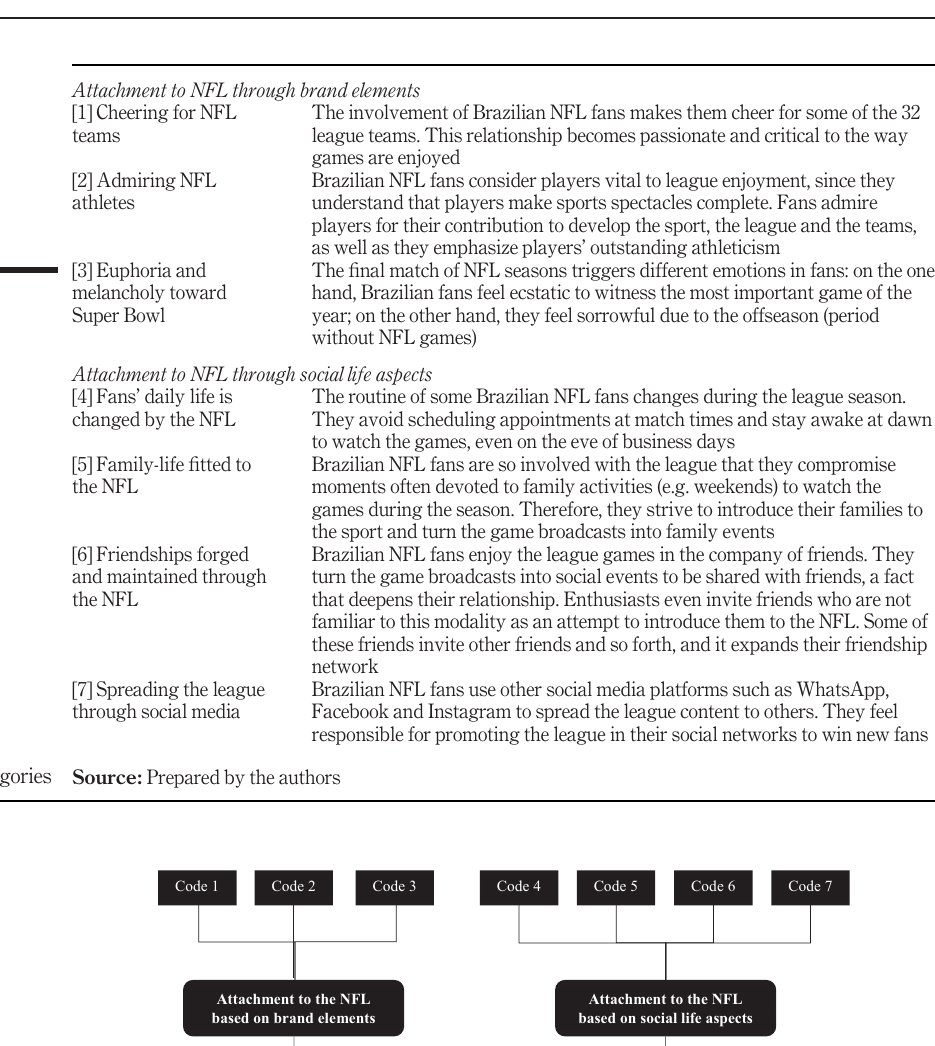
Figure 1. Relationship between codes and